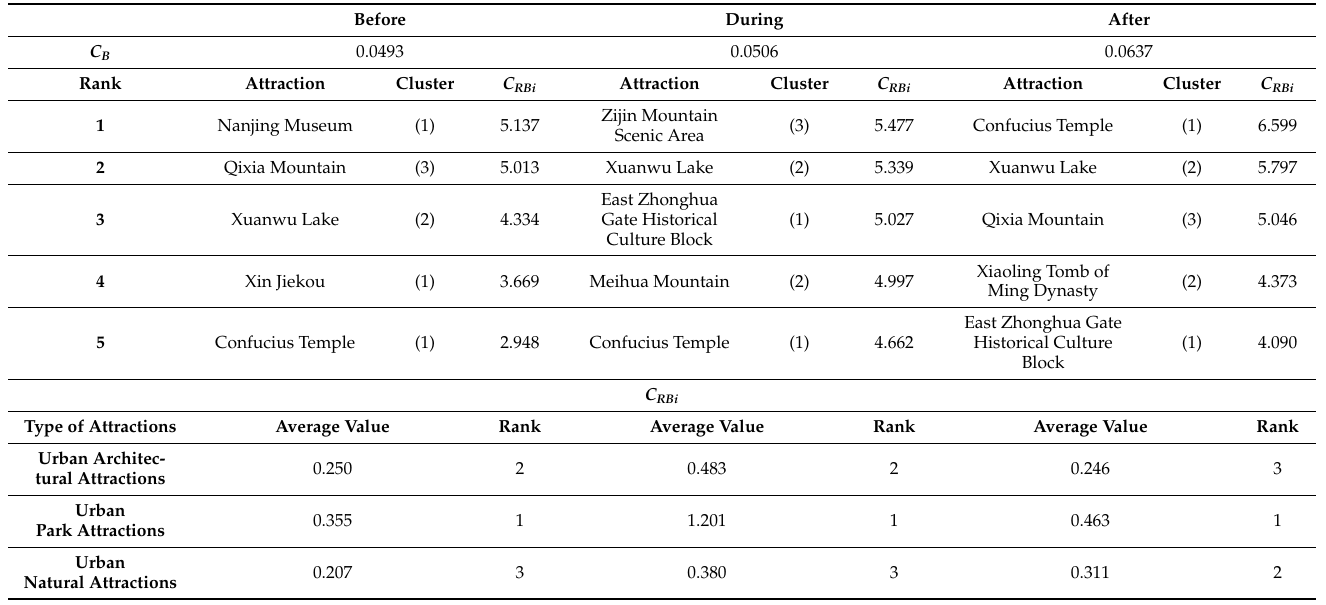
Table 6. Network and node betweenness